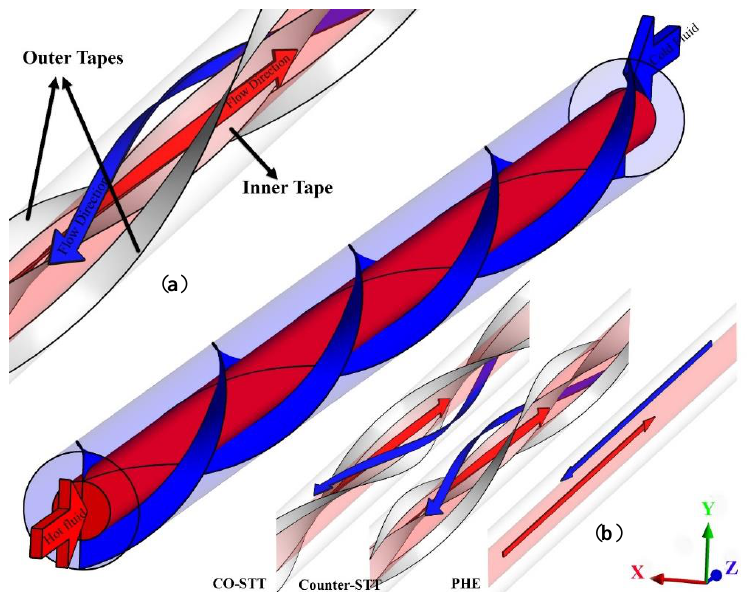
Figure 1. ( a ) Current study Schematic diagram with overlapped twisted tapes; and ( b ) comparison of the different proposed cases.